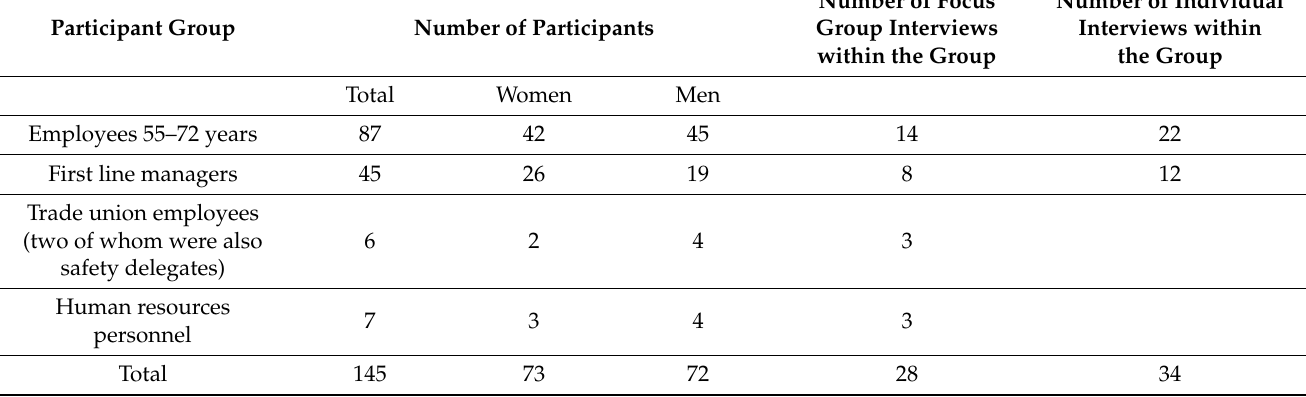
Table 1. Distribution of the study